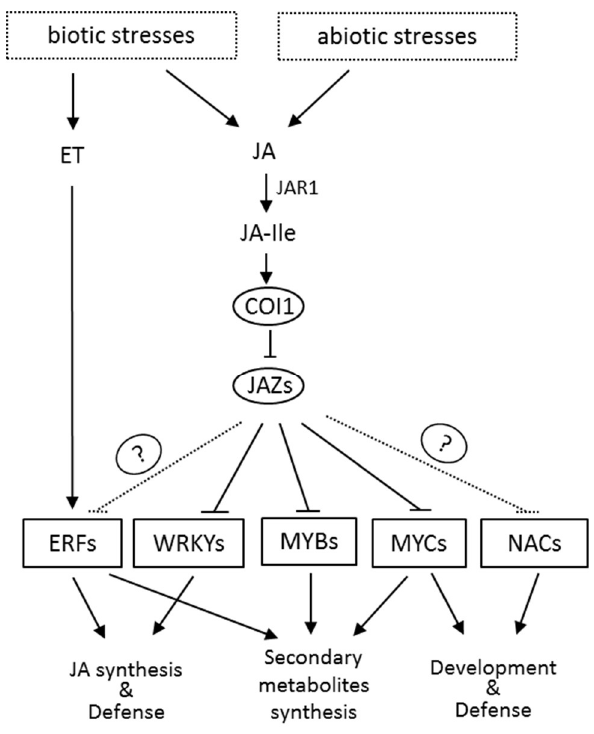
Figure 3. The regulation network of the jasmonic acid signaling pathway. Biotic and abiotic stresses induce the synthesis of JA, which can be converted to the biologically active JA-Ile by JAR1. Perception of JA-Ile by its receptor COI1 triggers the degradation of JAZ repressors, leading to the release of downstream transcription factors and the regulation of JAs-responsive genes in various processes. The question marker indicates an adaptor protein which is not identified yet.